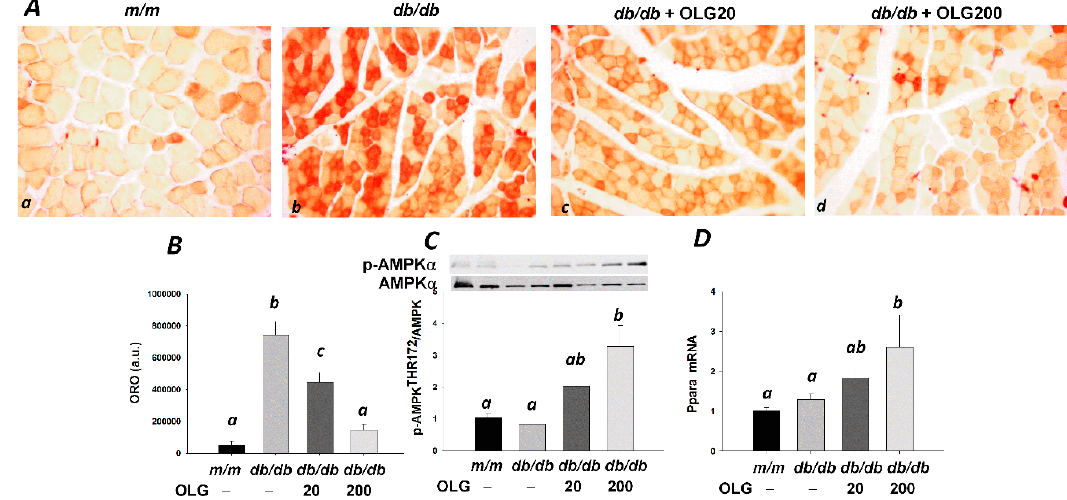
Figure 4. Oil red O (ORO)-stained tibialis anterior muscle sections ( Aa – d ) in m/m and db/db mice with or without oligonol (OLG) supplementation (200×); ( B ) Quantification of neutral lipids stained with ORO solution in tibialis anterior muscle ( n = 3/group); ( C ) Representative blots of AMPK α and phospho-AMPK α (Thr172) are shown ( n = 5–6/group); ( D ) Ppara mRNA expression level is expressed as mean ratio to control after normalization with 18S mRNA levels ( n = 5–6/group). Fold differences were calculated using the ΔΔ Ct method. Values presented are mean ± SEM. Significance ( p < 0.05) among groups is denoted by different letters.